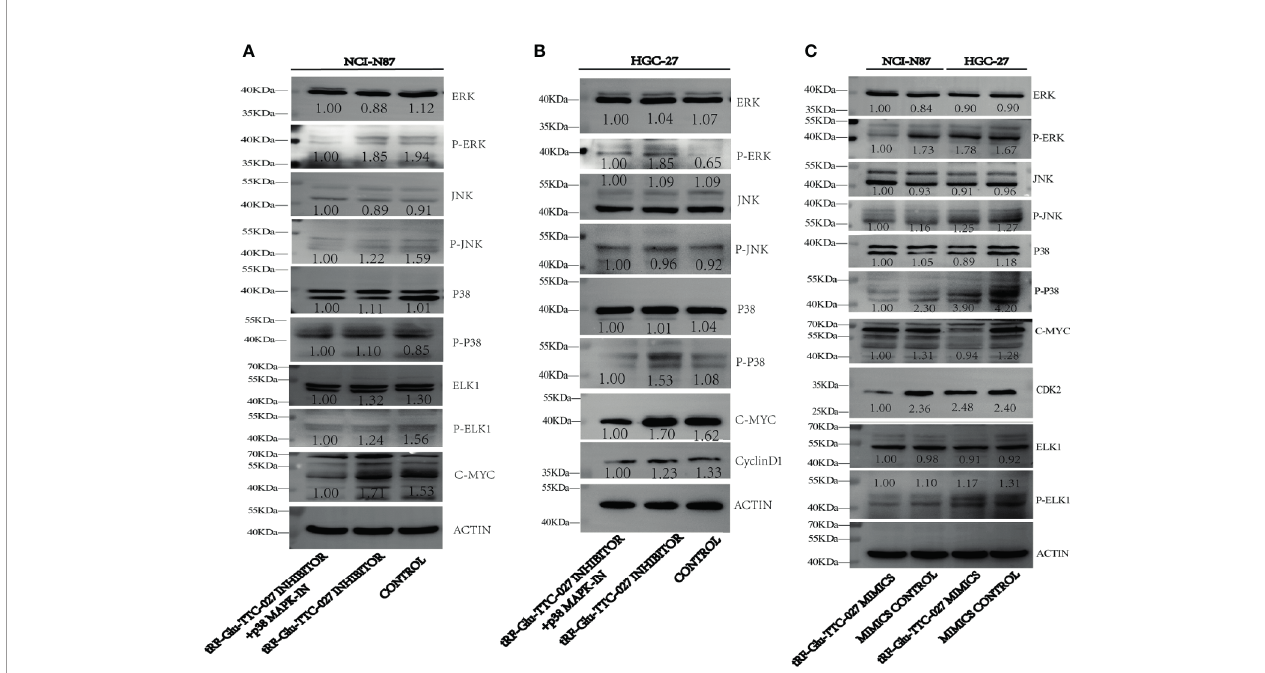
FIGURE 6 | tRF-Glu-TTC-027 in fl uenced the expression of related proteins in the MAPK signaling pathway. (A, B) tRF-Glu-TTC-027 inhibitor could upregulate the expression of p-p38 and c-Myc in HGC-27, and p-ERK, p-p38, and c-Myc in NCI-N87. p38 MAPK-IN could suppress the expression of p-ERK, p-p38, Elk1, p-Elk1, c-Myc, cyclinD1 in HGC-27 and NCI-N87. (C) tRF-Glu-TTC-027 mimics could inhibit the expression of p-ERK, p-JNK, p-p38, c-Myc, CDK2, p-ELK1 in NCI-N87, and p38, p-p38, c-Myc, p-ELK1 in